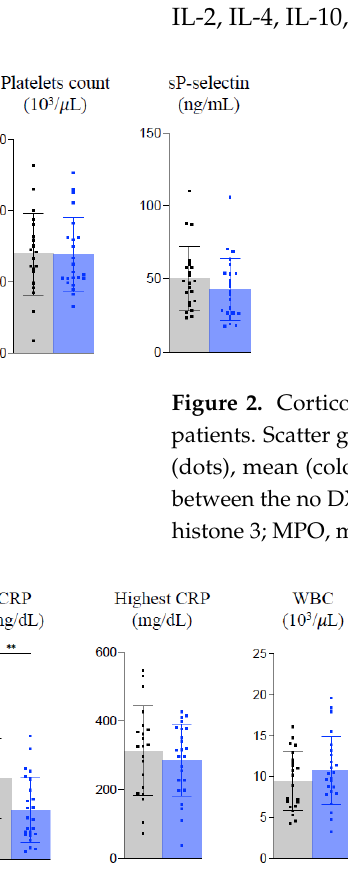
Figure 3. Corticosteroid effects on ubiquitous inflammatory reaction in critical COVID-19 patients. Scatter graphs of ubiquitous proinflammatory cytokines. Individual values (dots), mean (colored rectangle), and standard deviation are presented on the graphs. * p < 0.05, ** p < 0.01 between the no DXM group and the DXM group. CRP, C-reactive protein; IL, interleukin; TNF α , tumor necrosis factor α ; WBCs, white blood cells.